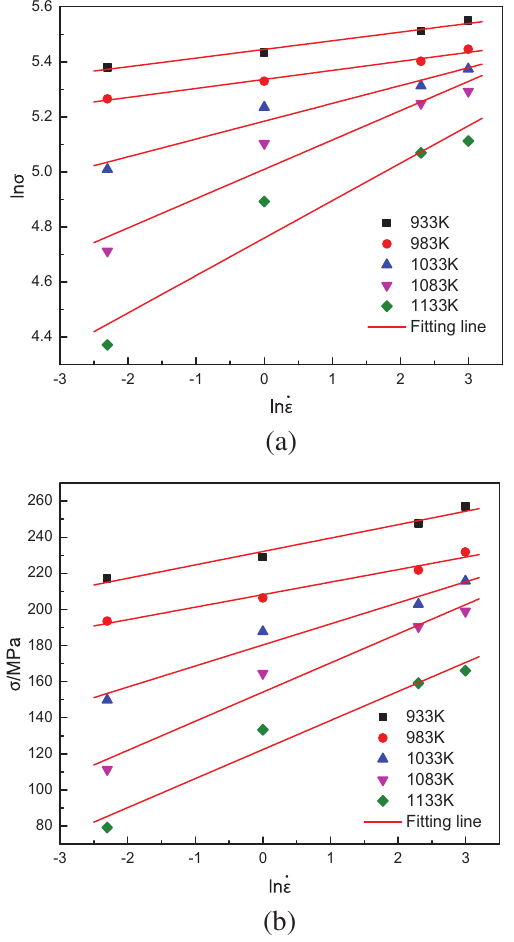
Figure 16: Relationship between (a) ln ( σ ) and ln _ ε ð Þ ; (b) σ and ln _ ε ð Þ .